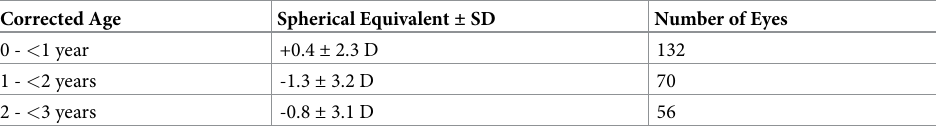
Table 1. Mean refractive error in eyes treated with laser for retinopathy of